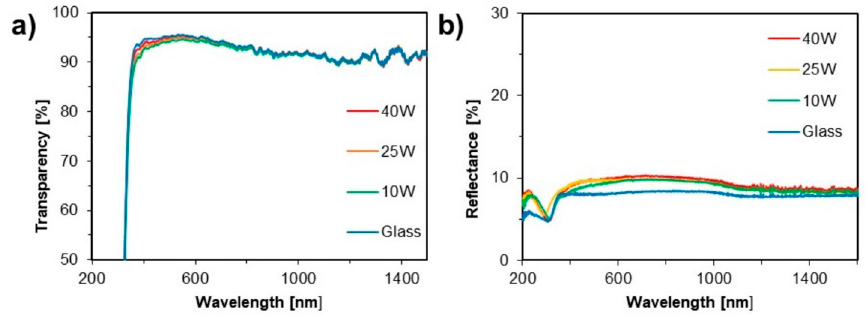
Figure 5. ( a ) Transmittance and ( b ) reflectance spectra of the a-C:H coatings produced by the ion source at different RF power.